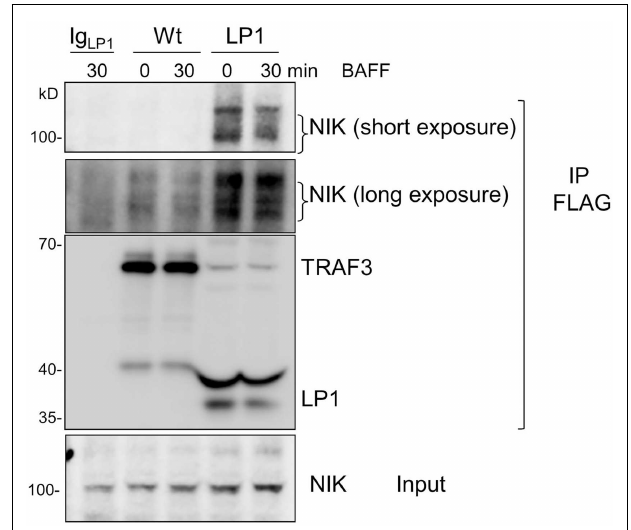
FIGURE 5 | Enhanced association of LP1TRAF3 with NIK . CH12.TRAF3 − / − cells expressing FLAG-taggedWt or LP1TRAF3 were untreated or stimulated with 500ng/ml of BAFF.Whole cell lysates were prepared and immunoprecipitated with anti-FLAG Ab.Western blots of immunoprecipitates were probed for NIK and FLAG. Both short and long exposures of the blot are shown due to differences in NIK association betweenWt and LP1TRAF3. Data shown are representative of two similar